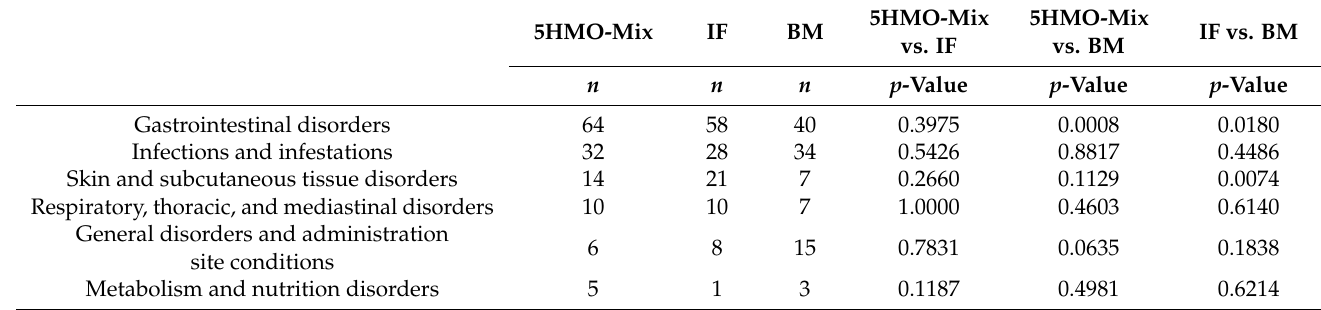
Table 5. Number of infants in the safety set ( n = 311) with the most abundant adverse events reported during the study period (V1–V6) categorized by MedDRA v23.1. Primary SOC. Please see Table S3 for full overview of all